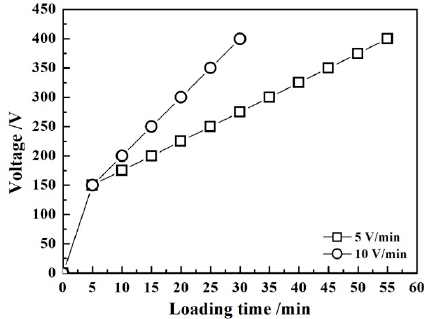
Figure 1. Voltage loading method for MAO experimental.